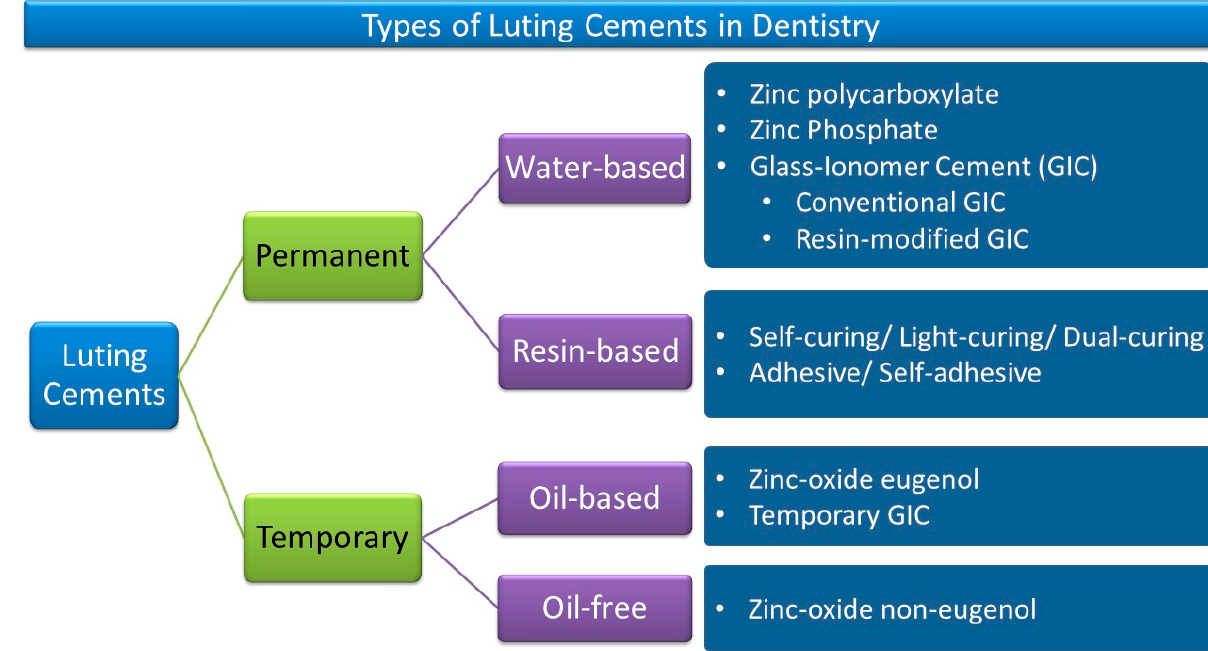
Figure 1. Various luting cements in dentistry with common examples.